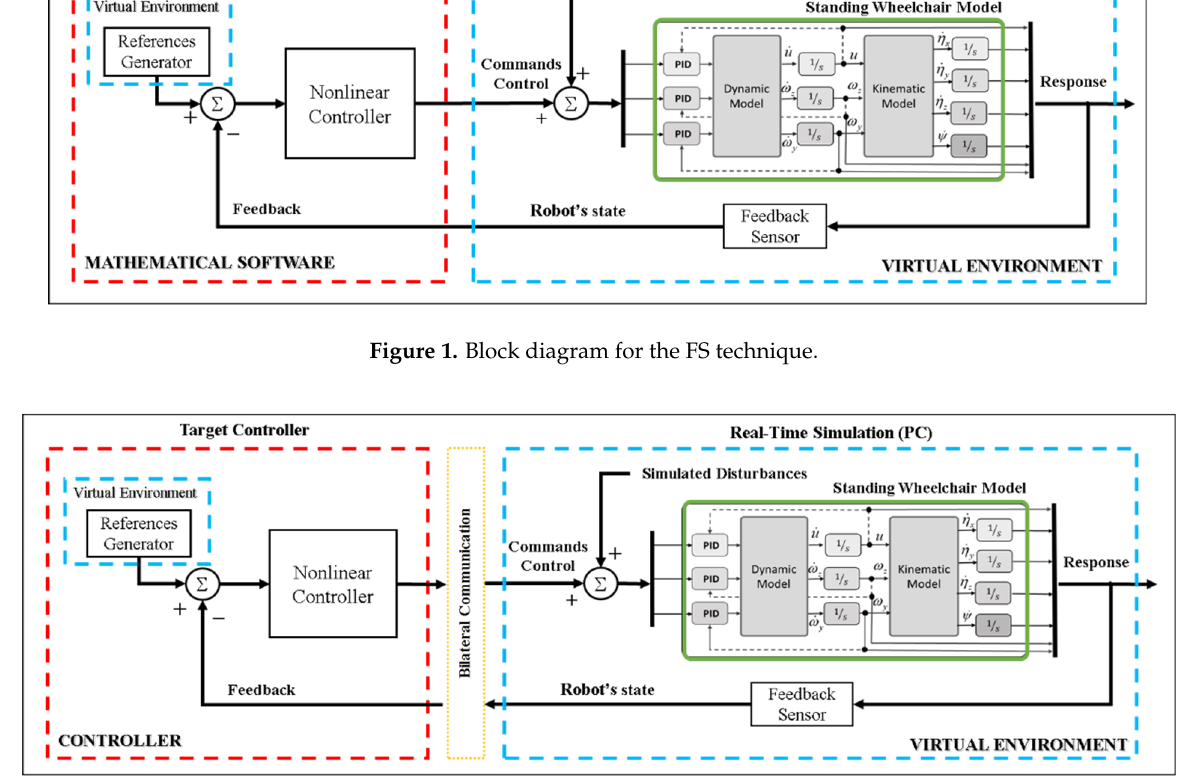
Figure 2. Block diagram for the HIL technique.